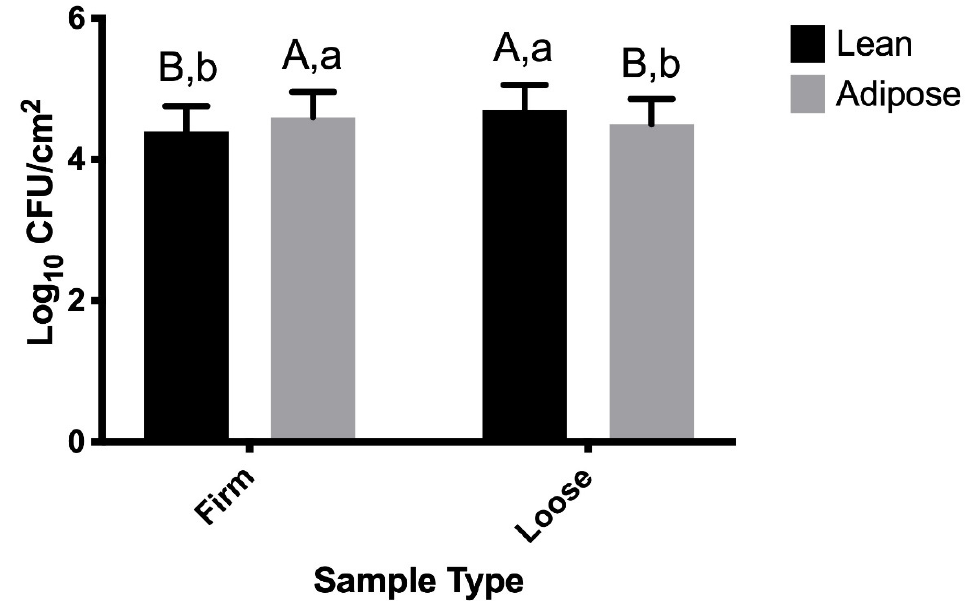
Figure 1. Populations of Shiga toxin-producing Escherichia coli (STEC) cells grown in tryptic soy broth (TSB) represent loose and firm attachment to lean and adipose beef brisket tissues. Sample type × tissue type was significant ( p < 0.0001). As the time × sample type × tissue type interaction was not significant ( p > 0.05), data for each time point are combined. A,B Observations with different superscripts within sample type (firm vs. loose) vary statistically ( p ≤ 0.05). a,b Observations with different superscripts within tissue type (lean vs. adipose) vary statistically ( p ≤ 0.05).